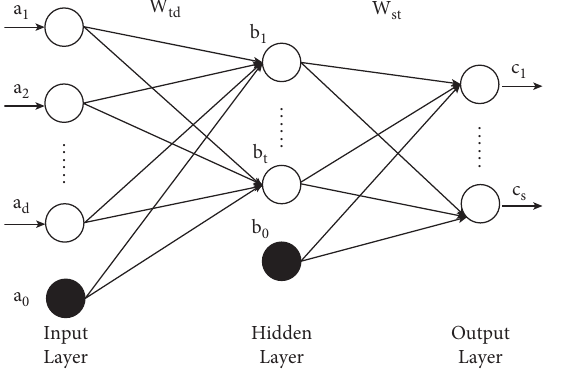
Figure 1: The architecture of BP-MLL